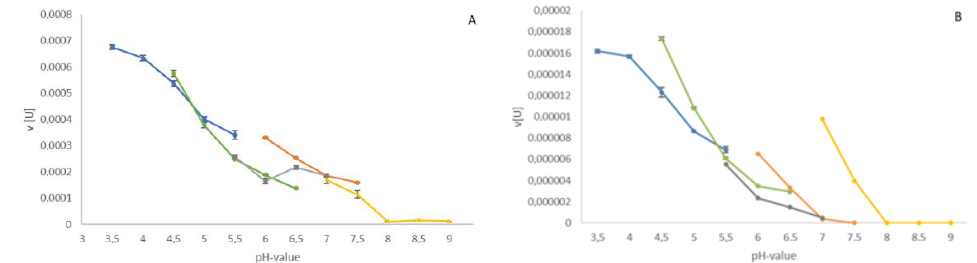
Figure 3. pH pattern of Arion using the following buffer systems: acetate/NaOH (blue), cit- rate/NaOH (green), MES (grey), phosphate (orange), and Tris/HCl (yellow). ( A ) A. lusitanicus ; ( B ) A. vulgaris . Data points represent mean values of duplicate measurements in units with correspond- ing standard deviation. Negative values, due to conversion into units, were set to zero. For experi- mental details see Section 2.6.